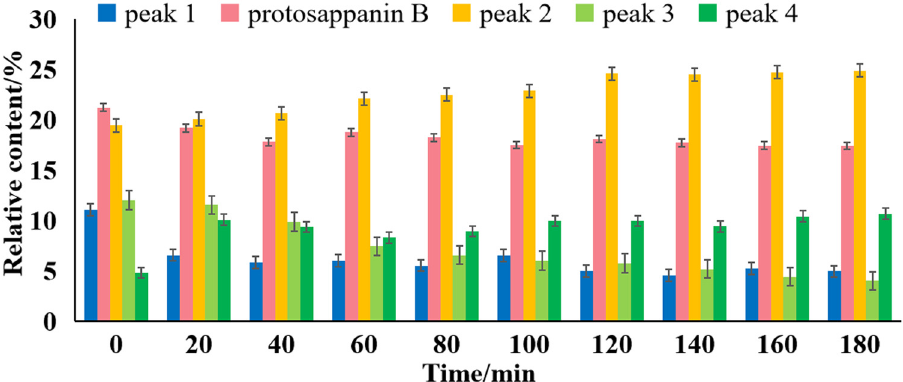
Figure 3: The relative content of characteristic peaks at di ff erent decoction